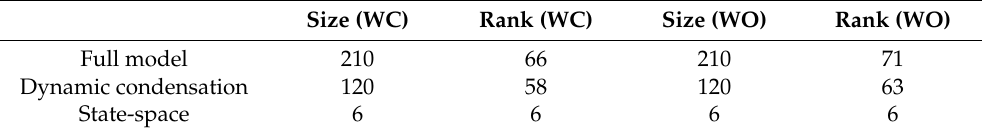
Table 4. Judgment indexes of controllability and observability before and after model reduction.